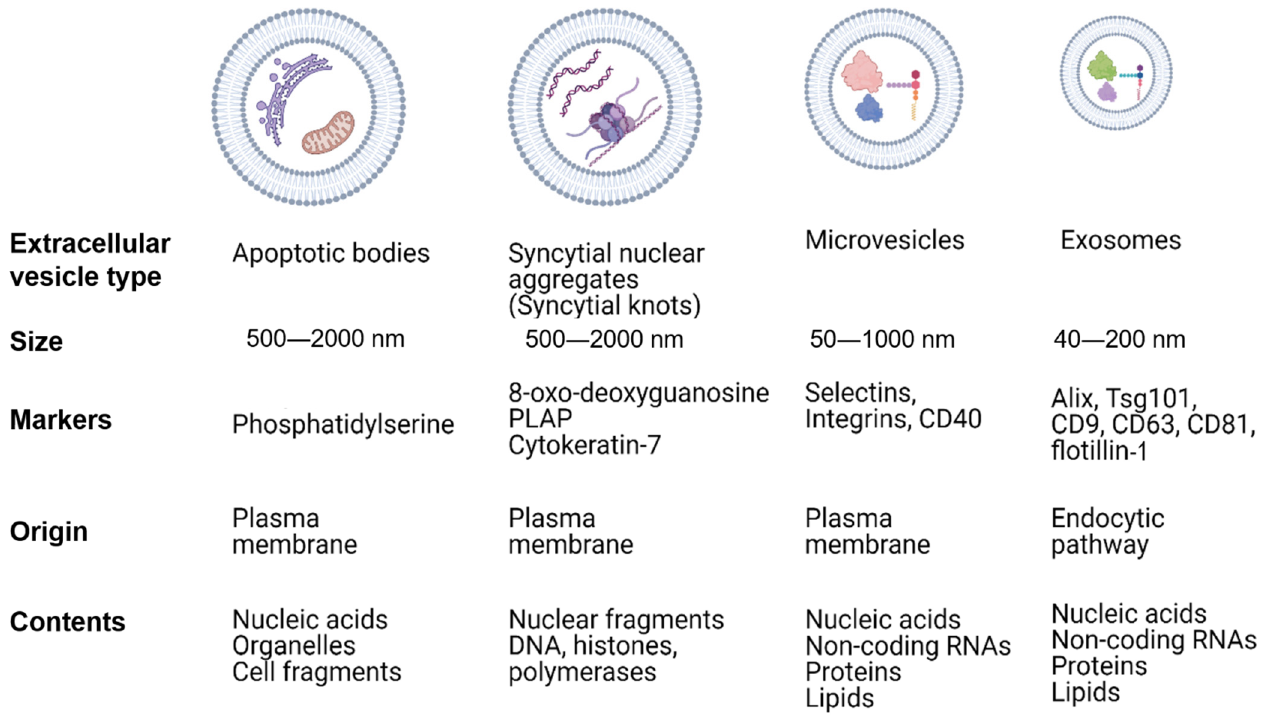
Figure 1. Characteristics of extracellular vesicles based on size, surface marker expression, origin, and cargo.